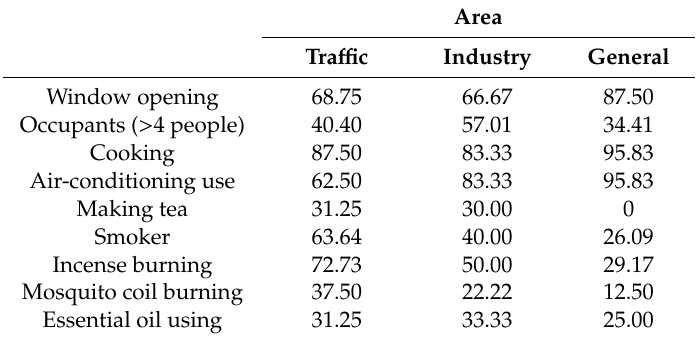
Table 2. The percentage (%) of household characteristics in traffic, industry, and general areas.